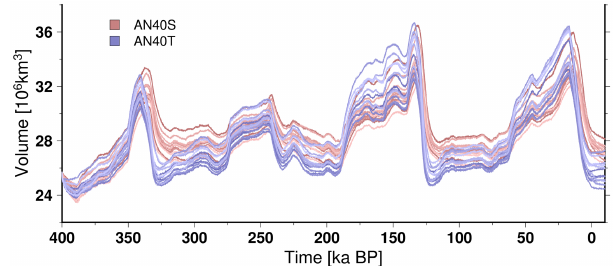
Figure 14. Simulated total ice sheet volume evolution over the last 400kyr for the 12 ensemble members showing the lowest RMSE in Sect. 3 when using the flux at the grounding line computed from Schoof (2007) (AN40S, shades of red) and Tsai et al. (2015) (AN40T, shades of blue). The glacial–interglacial difference in ice volume for the last termination corresponds to about − 10 to − 20m of global sea level rise equivalent depending on the